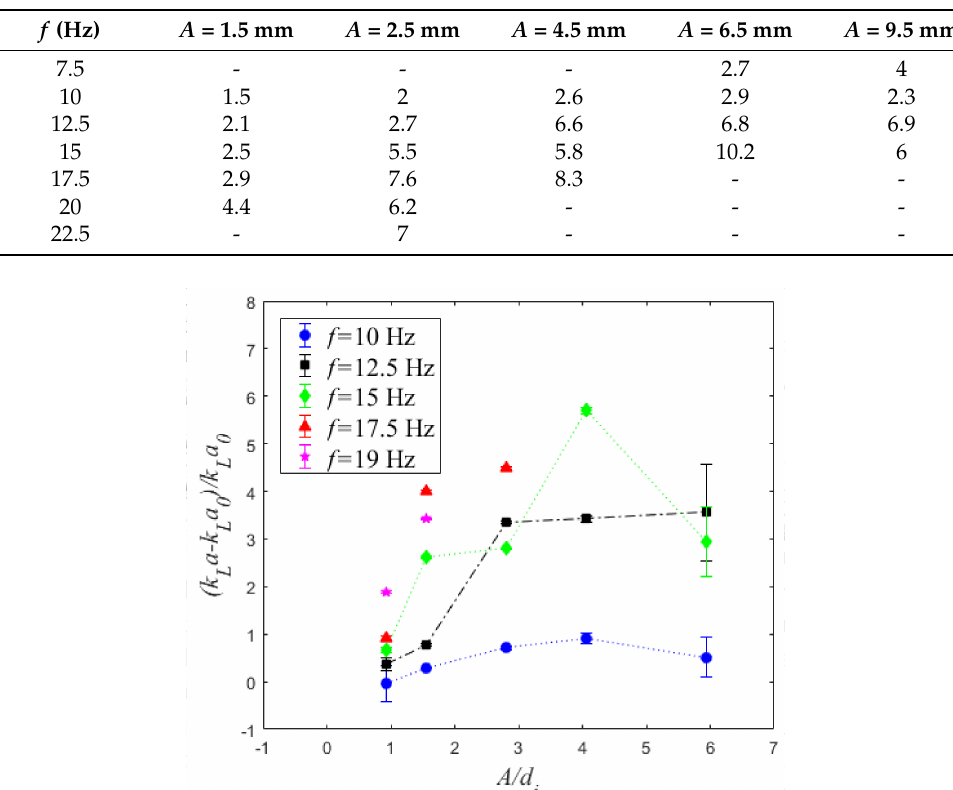
Figure 15. Non-dimensional mass transfer coefficient versus non-dimensional vibration amplitude for f = 10, 12.5 and 15 Hz ( U SG = 5.0